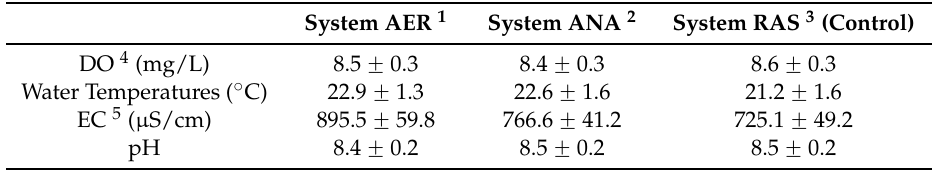
Table 2. Means and standard deviation of main measured water parameters during the 35 days of the experiment ( n = 11).